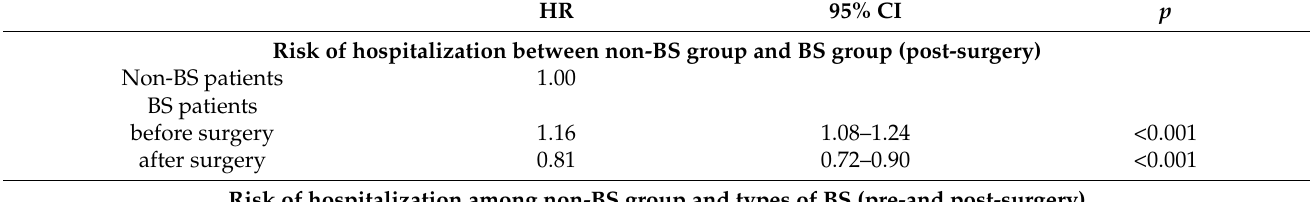
Table 4. Risk of hospitalization by bariatric surgery (upper part) and by type of surgery (lower part). HR 95% CI p Risk of hospitalization between non-BS group and BS group